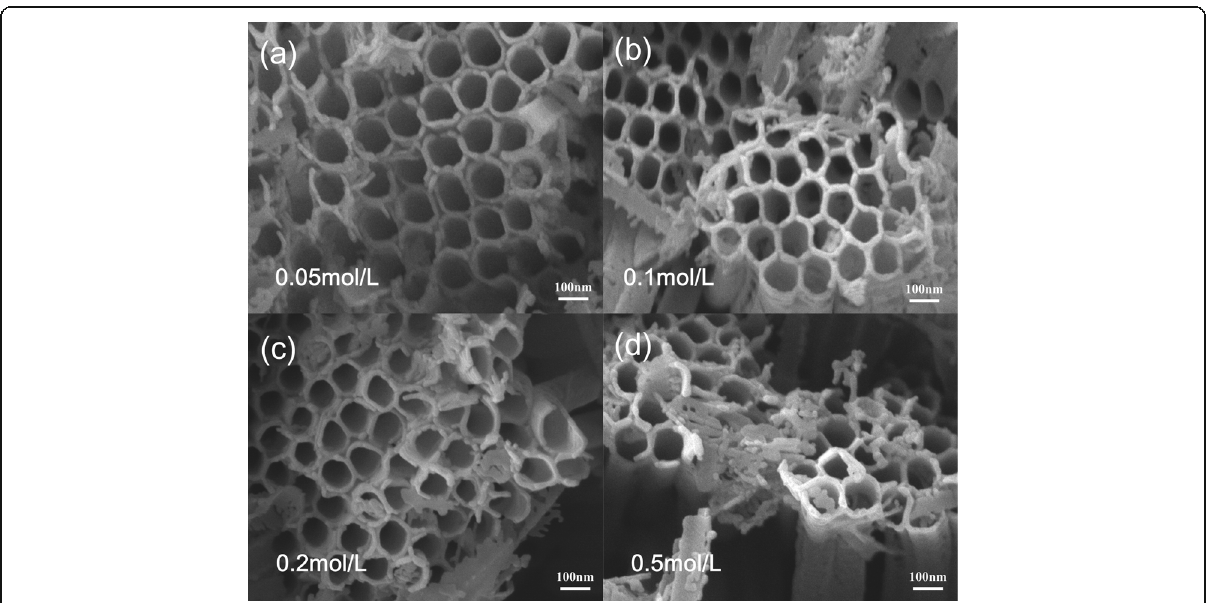
Fig. 5 SEM images of the CeO 2 /TiO 2 heterojunctions with different Ce(NO 3 ) 3 solution concentration: a sample immersed in 0.05 mol/L Ce(NO 3 ) 3 ; b sample immersed in 0.1 mol/L Ce(NO 3 ) 3 ; c sample immersed in 0.2 mol/L Ce(NO 3 ) 3 ; and d sample immersed in 0.5 mol/L Ce(NO 3 ) 3